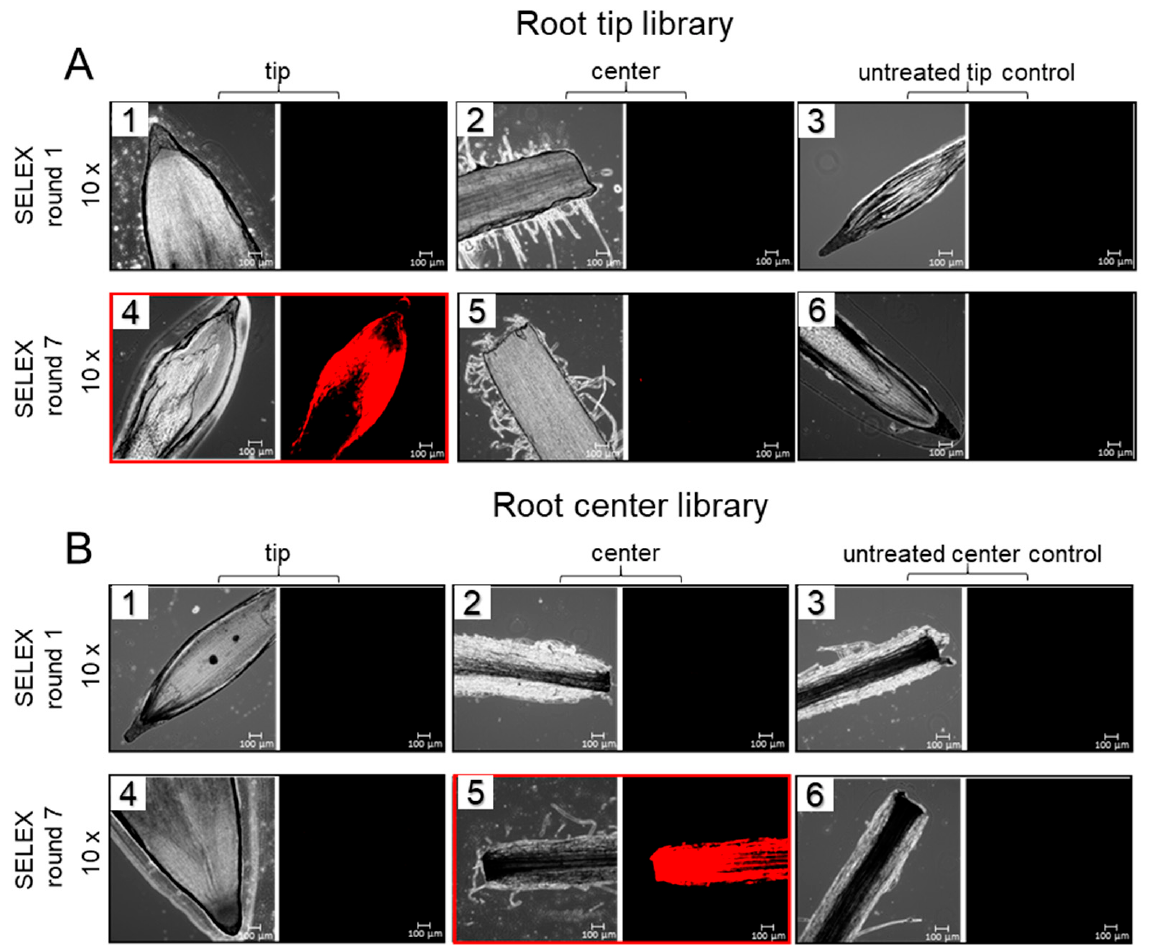
Figure 3. Visualization of the specific fluorescence labeling of the root developmental zones of H. vulgare L. by Cy5-labeled root tips and root center aptamer libraries (excitation: 635 nm) using fluorescence and light0transmitting filters at a 10× magnitude. In the process, the aptamers were added to the desired and opposite target sites, and, furthermore, the targets without aptamer treatment are shown as controls. ( A ) The target sites with root tip aptamers are displayed, and in ( B ), those with root center aptamers are shown. The upper panel shows the libraries of the first FluRoot-SELEX round and the lower panel represents the seventh round. The plants used for the experiment were cultivated for 3 days, and 10 pmol of aptamers were used. Microscopy was per- formed using a Leica DMi8 coded (Leica Microsystems CMS GmbH, Wetzlar, Germany) under transmitted light and using the Y5 filter (excitation: 590–650 nm and emission: 662–738 nm) for fluorescence imaging.